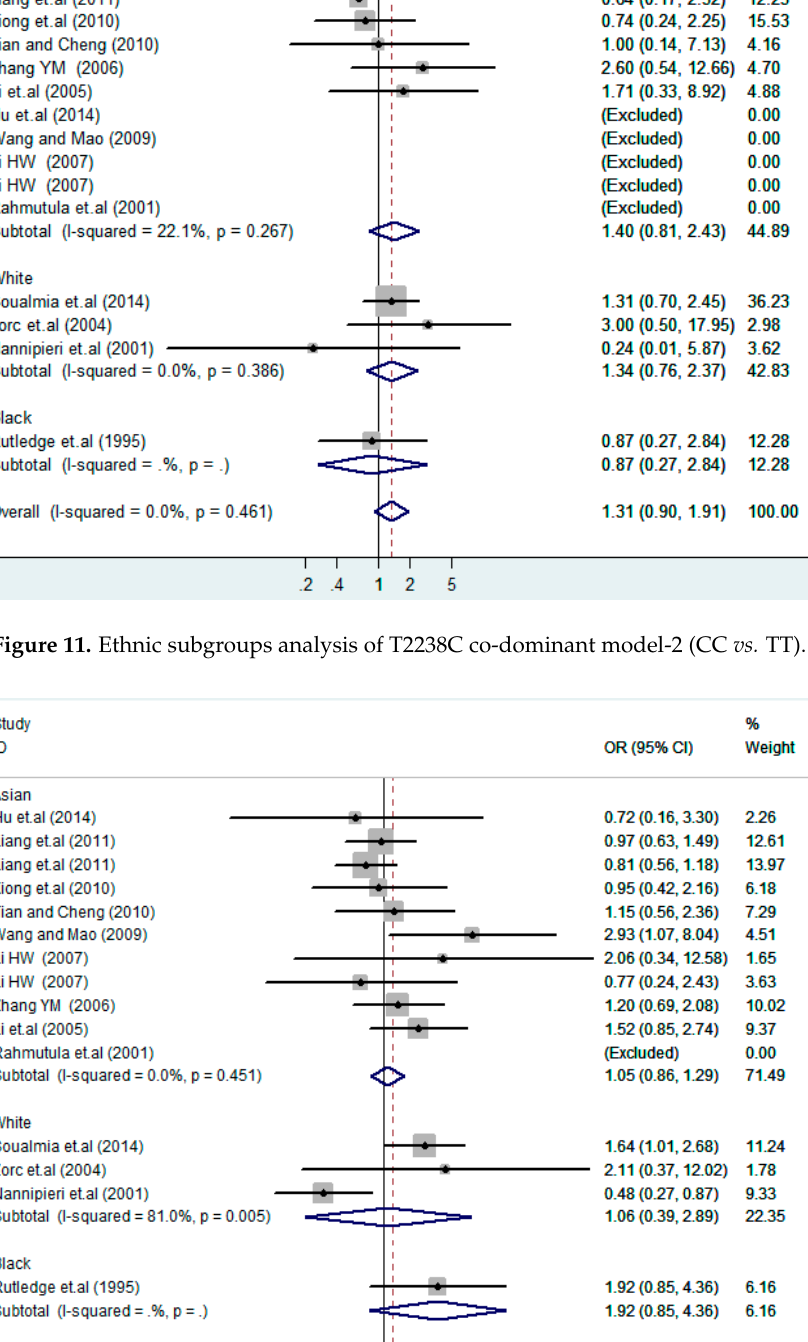
Figure 12. Ethnic subgroup analysis of T2238C dominant model (CC + TC) vs. TT.